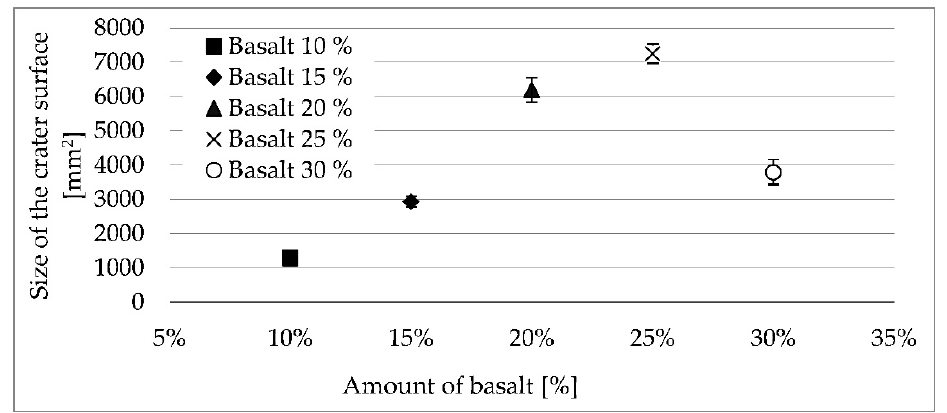
Figure 17. Diameter of the entrance crater according to the individual percentage substitutions.